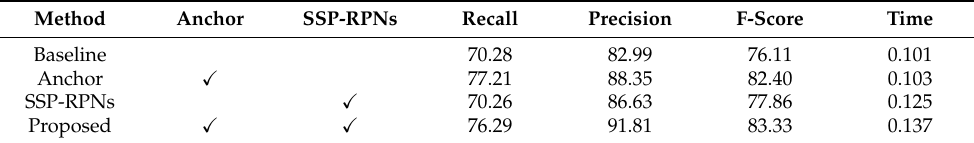
Table 2. Results on ablation study.